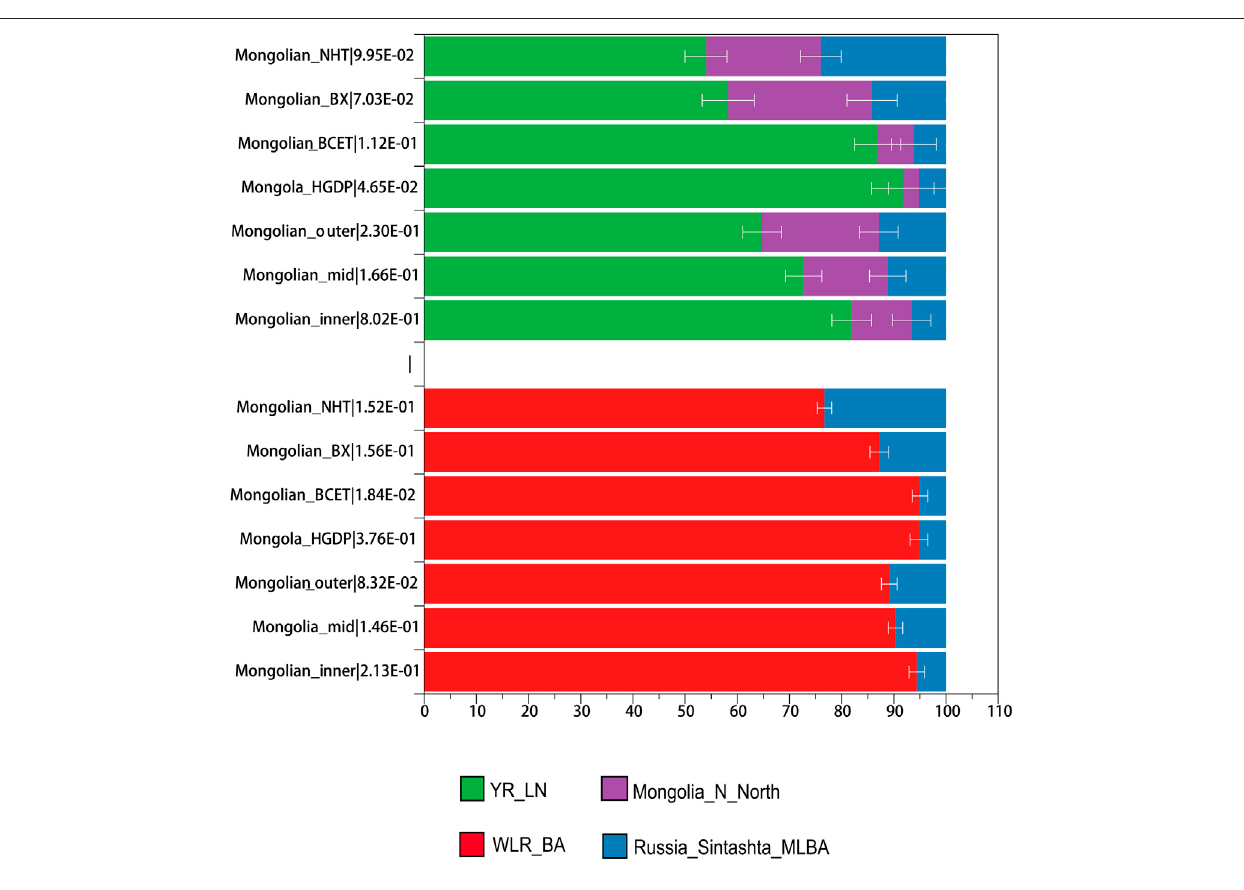
FIGURE 4 | qpAdm-based admixture models for Mongolian